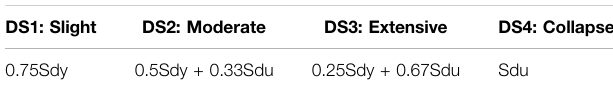
TABLE 3 | Damage states used in the derivation of fragility